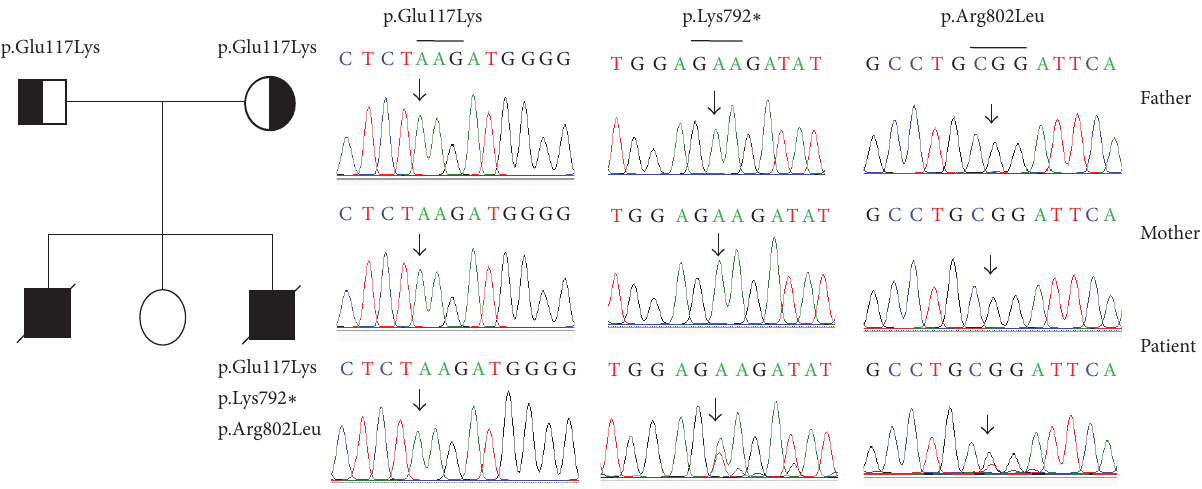
Figure 3: Mutations of the NPHS1 gene were identified by sequencing in patient 3 and his parents. The pedigree and mutations of the NPHS1 gene were identified in the family of patient 3, including of a homozygous variant p.Glu117Lys, a heterozygous mutation p.Lys792 ∗ , and a heterozygous mutation